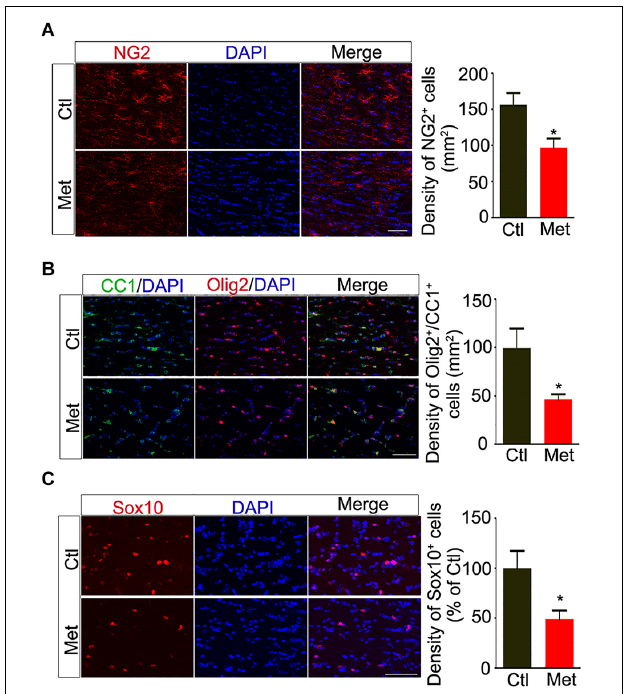
FIGURE 4 | Analyses of the constitution of oligodendroglial lineage cells after Met treatment. (A) Representative images showing immunofluorescence staining of NG2 positive cells in the frontal white matter of Ctl and Met mice. The right bar graph shows the density of NG2 positive cells ( n = 5 for each group). (B) Representative images showing immunofluorescence staining of CC1 positive cells and Olig2 positive cells in the frontal white matter of Ctl and Met mice. The right bar graph shows the density of Olig2/CC1 double-labeling cells ( n = 5 for each group). (C) Representative images showing immunofluorescence staining of Sox10 positive cells in the frontal white matter of Ctl and Met mice. The right bar graph shows the density of Sox10 positive cells ( n = 4 for each group). Scale bars = 50 µ m. The data are expressed as the mean ± SEM. * P < 0.05.